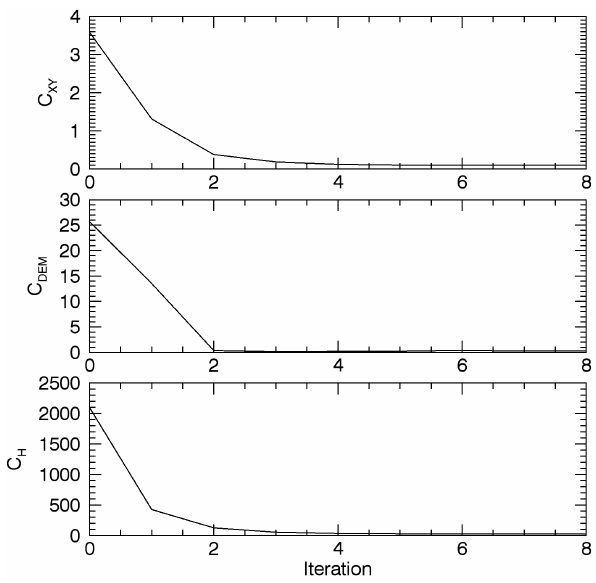
Figure 3. The convergence of the DEM iteration method is shown for Greenland as normalized sum of differences in (m). C H = P N 1 | h j + 1 i = 0 i N P N | XY j + 1 − XY j | . j is the iteration step, h j is the C XY = 1 i = 0 i i N slope corrected elevation, DEM j is the elevation model and XY j the relocated position after each iteration